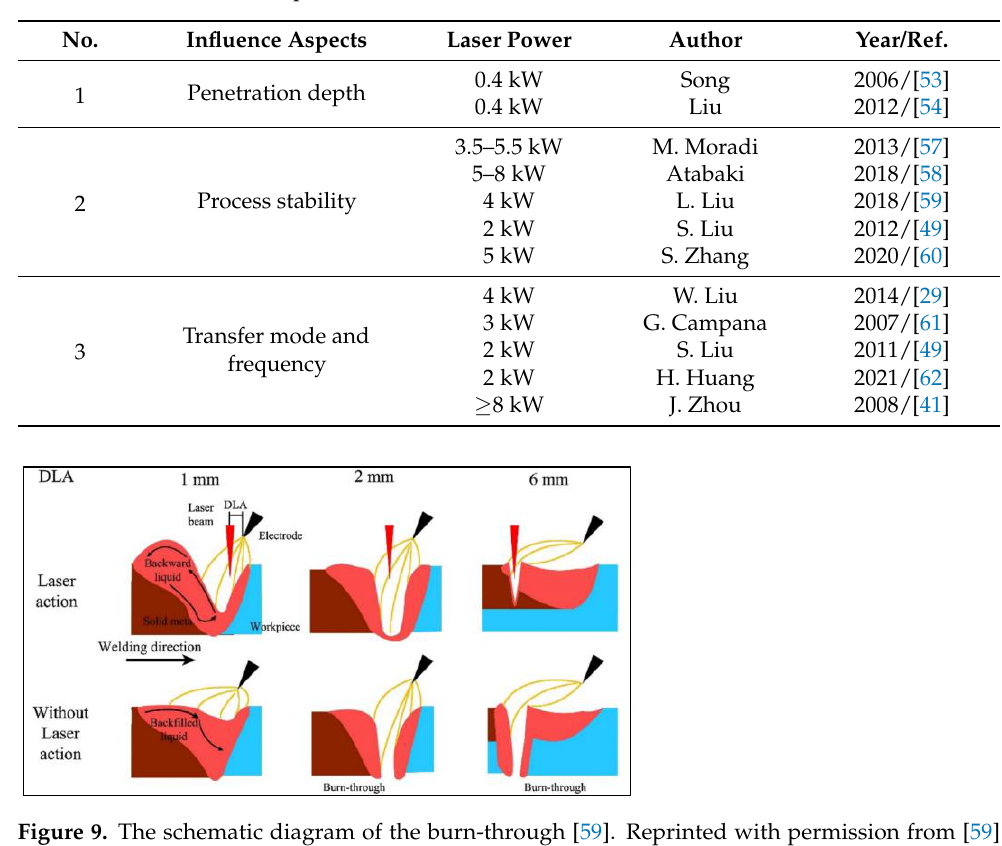
Table 1. Three influential aspects about D LA in this review.